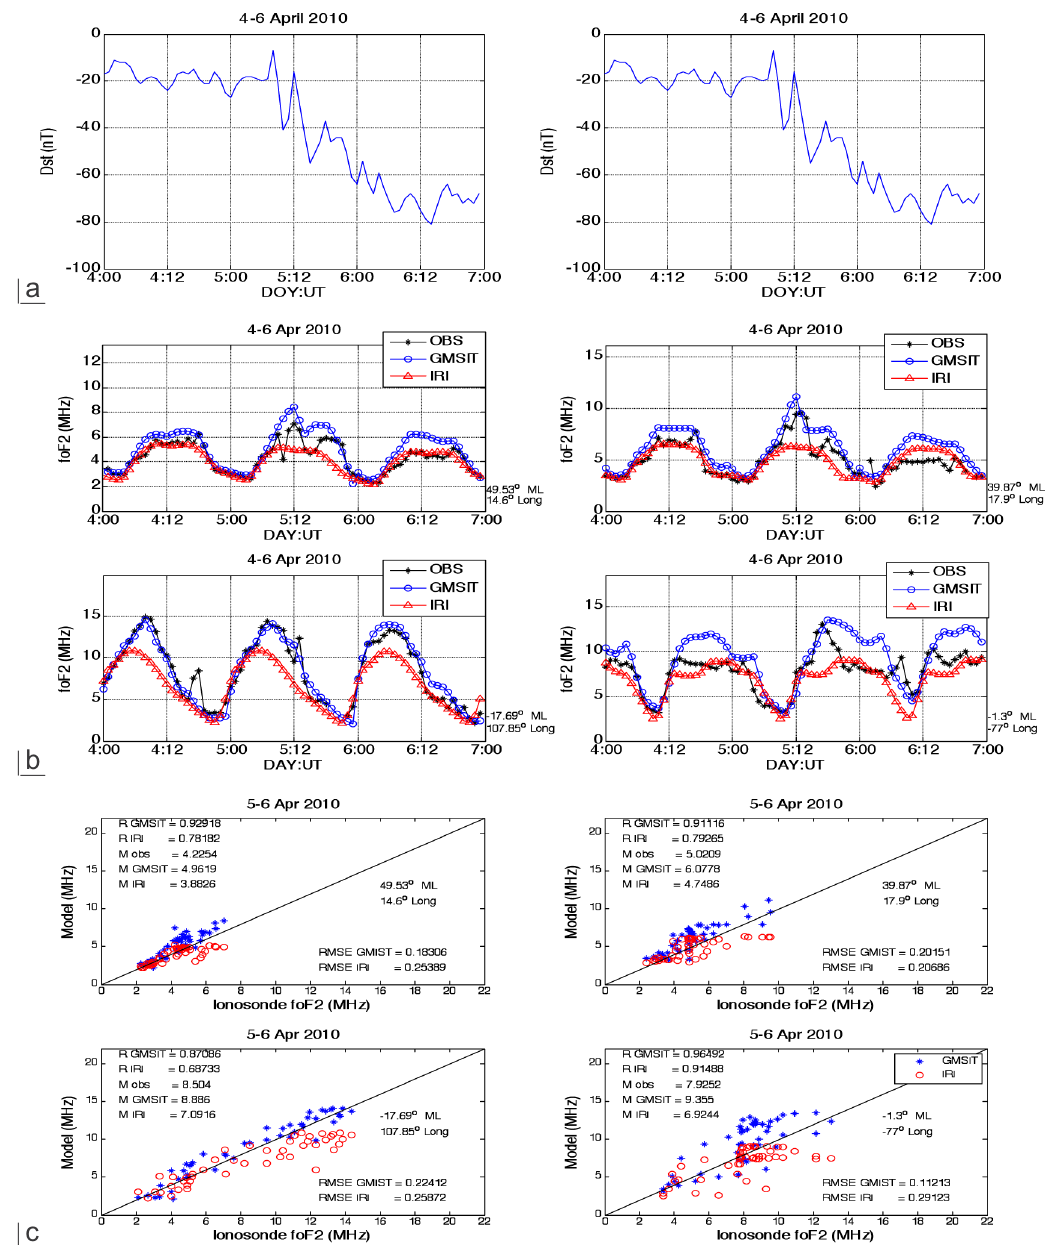
Figure 7. (a) Dst index, (b) comparison of GMIST foF2, IRI model and observations during April 4-6, 2010, and (c) scatter diagram GMIST foF2 and IRI vs foF2 data at ionospheric stations of different regions of the globe. The geomagnetic latitude and geographic longitude of each station is given at the low-right edge of each